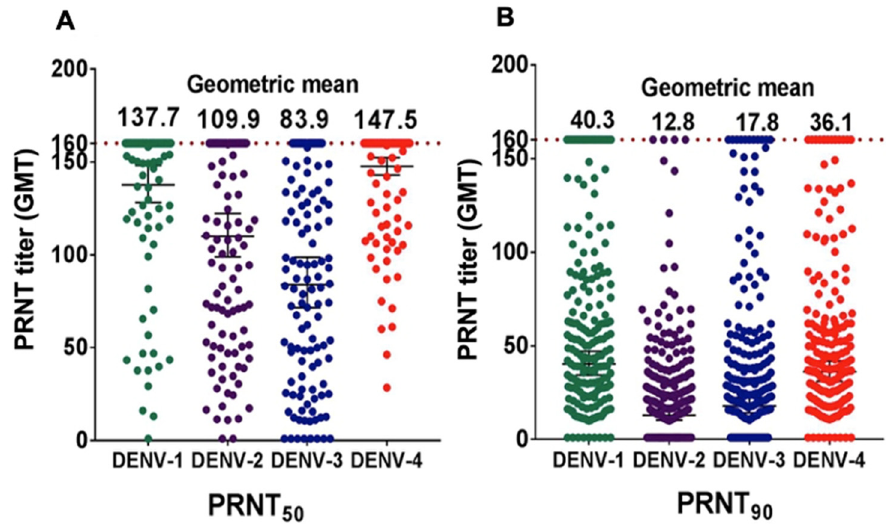
Figure 3. Geometric mean titers (GMT) of DENV NAb at two different thresholds: PRNT 50 ( A ) and PRNT 90 ( B ) ( n = 199). Neutralizing antibody (NAb) GMTs were interpolated using non-linear regres- sion.